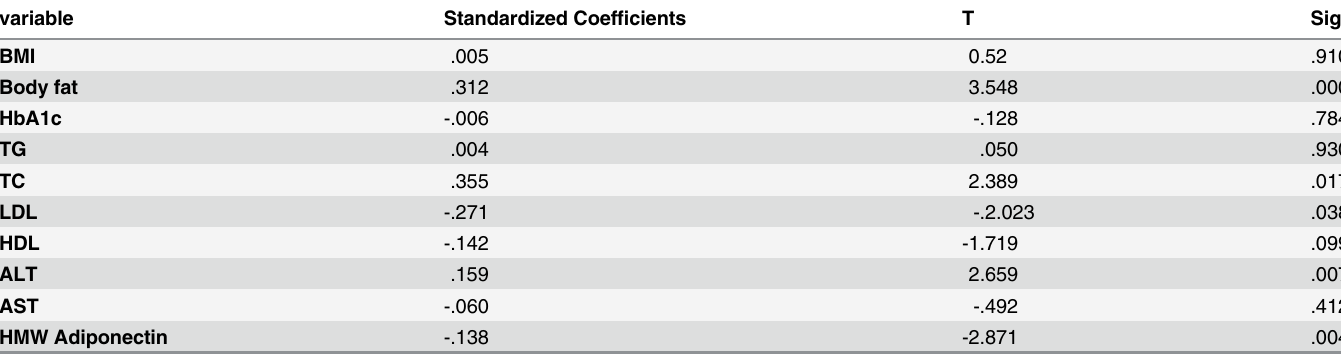
Table 5. Independent effects of markers of metabolic control on non-alcoholic fatty liver disease.